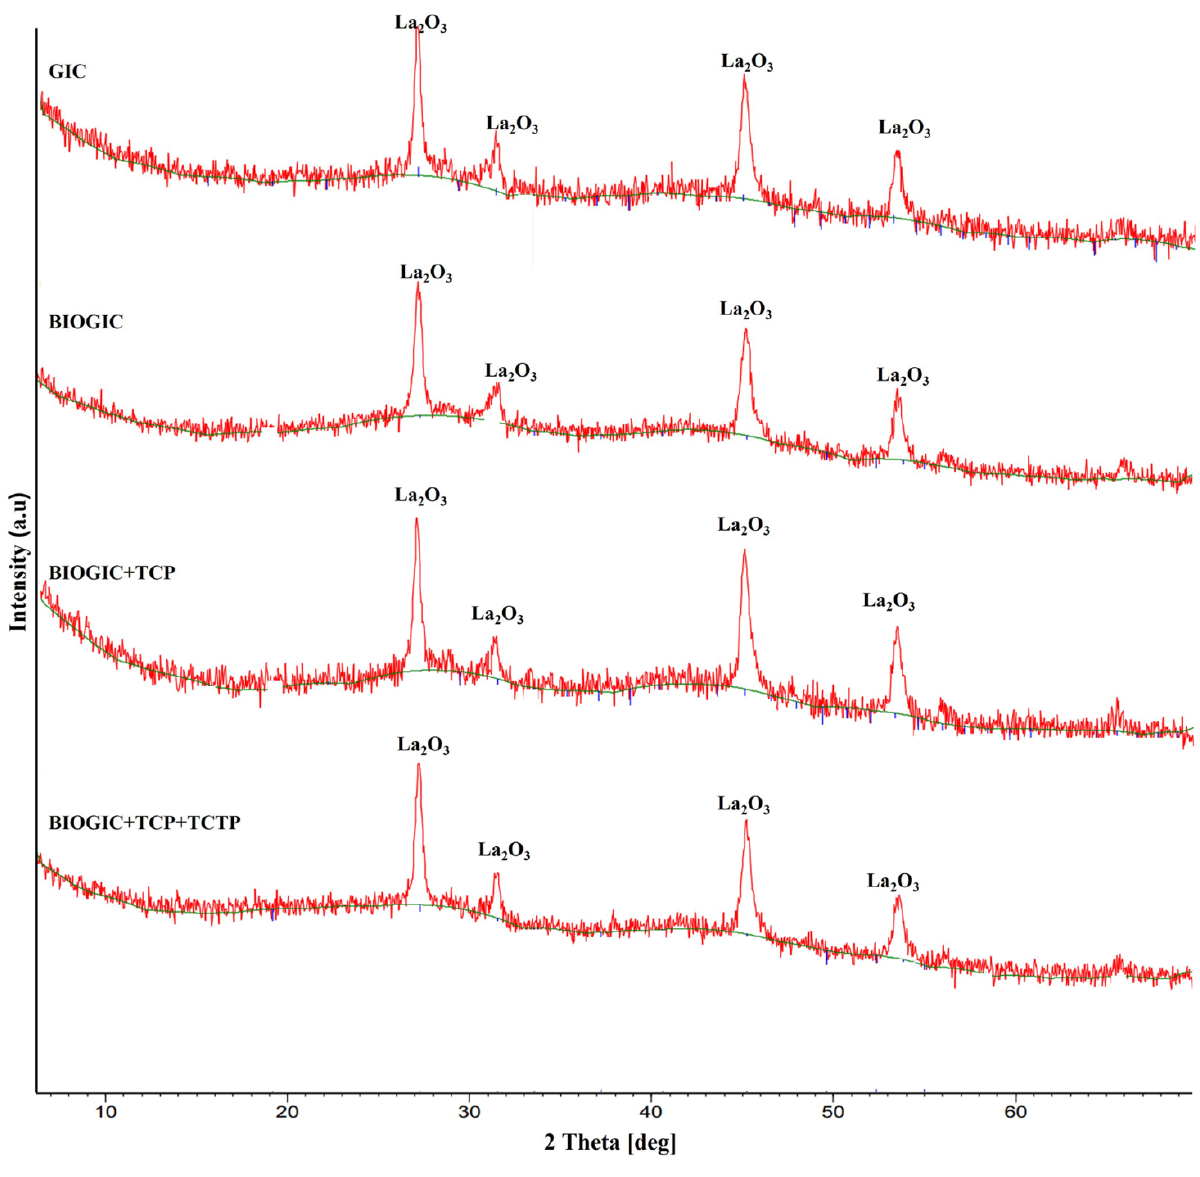
Figure 4. X-ray diffraction (XRD) patterns of GIC, BIOGIC, BIOGIC + TCP, and BIOGIC + TCP + TCTP.